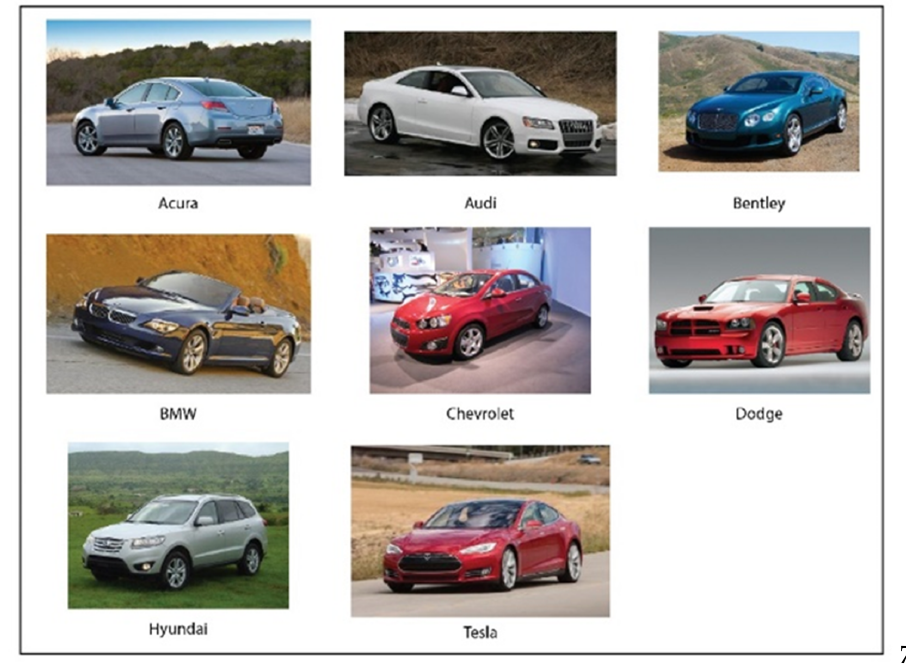
Figure 2. Sample images from the used dataset.